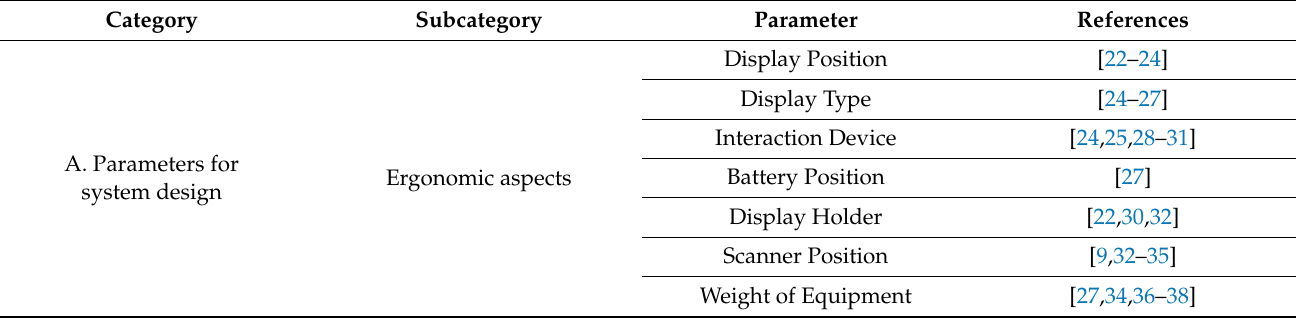
Table 3. Overview of the reviewed parameters for the design and investigation of the proposed system.